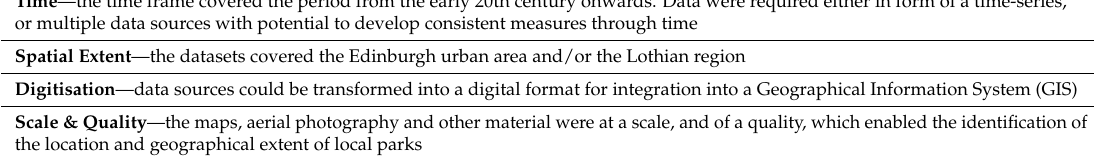
Table 1. Criteria for data